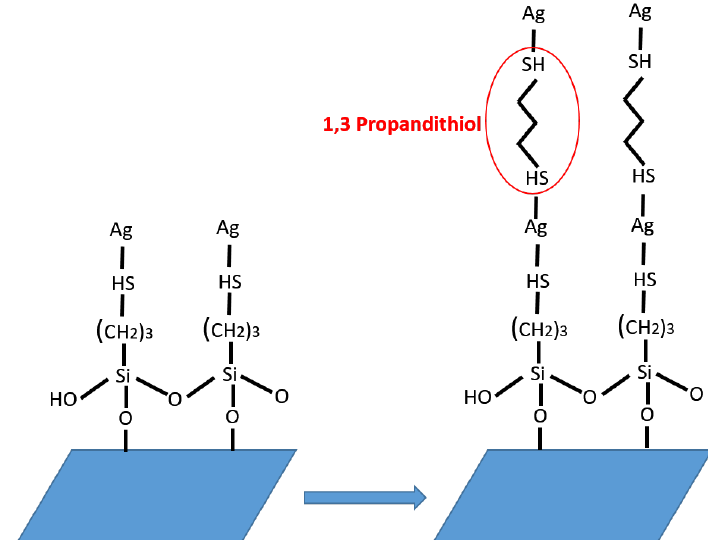
Figure 1. Schematic illustration for layer-by-layer (LBL) assembly of silver nanowires (AgNWs).